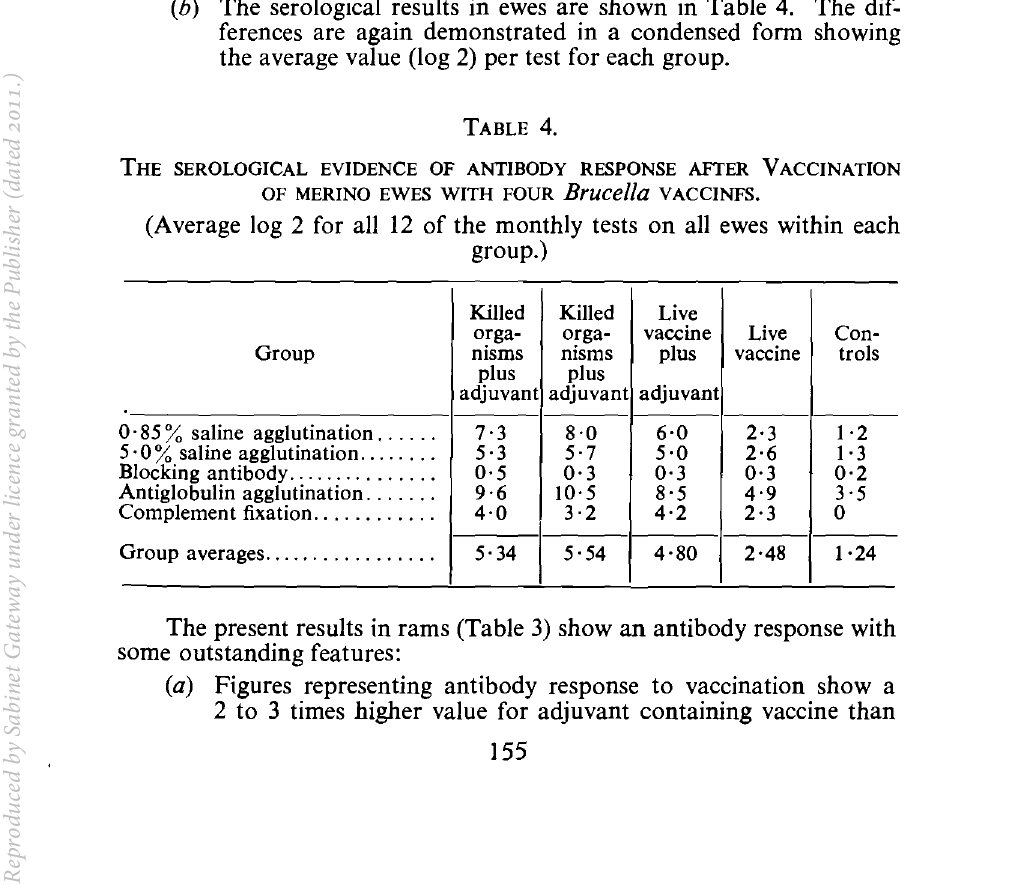
The differences are demonstrated by using numerals for the number of tubes showing positive reactions in each test of each serum specimen, and determining the average (log 2) for all tests on each group of rams. These figures show an overwhel ming superiority in serum antibody response to adjuvant con containing vaccine. (See Table 3).